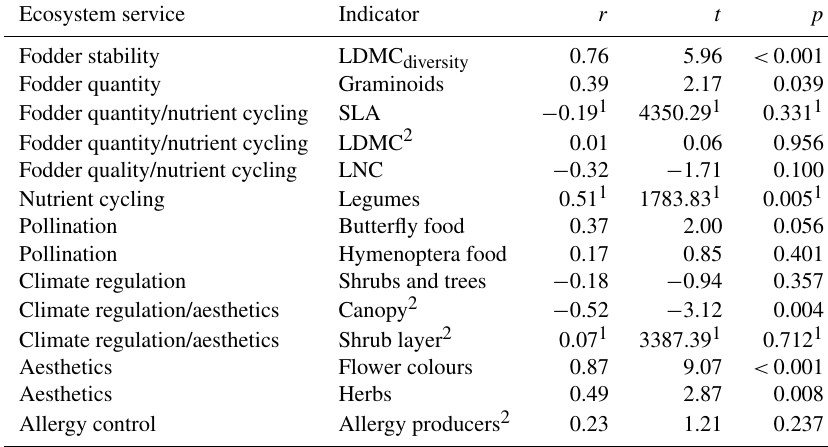
Table 3. Correlation ( r ) between plant species richness and ecosystem service (ES) indicators. Test statistics ( t ) and significance of the correlation ( p ) based on Pearson or Spearman 1 correlation tests.